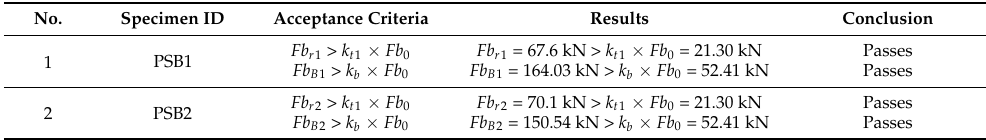
Table 4. Results of positive bending moment tests for PSB1 and